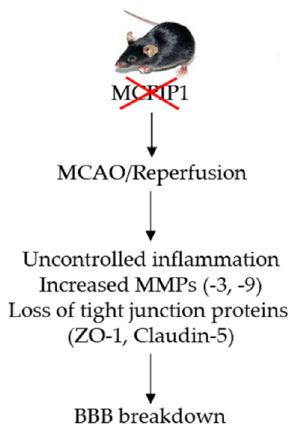
Figure 5. Schematic illustration of MCPIP1 deficiency enhancing blood–brain barrier (BBB) breakdown in mice subjected to middle cerebral artery occlusion (MCAO) / reperfusion injury. We show that deletion of MCPIP1 results in uncontrolled inflammation in the ischemic tissue, which increases the expression of MMP-3 / -9 and subsequent degradation of BBB-related tight junction proteins ZO-1 and claudin-5, leading to enhanced BBB breakdown in the MCPIP – / – mice upon ischemia / reperfusion injury.